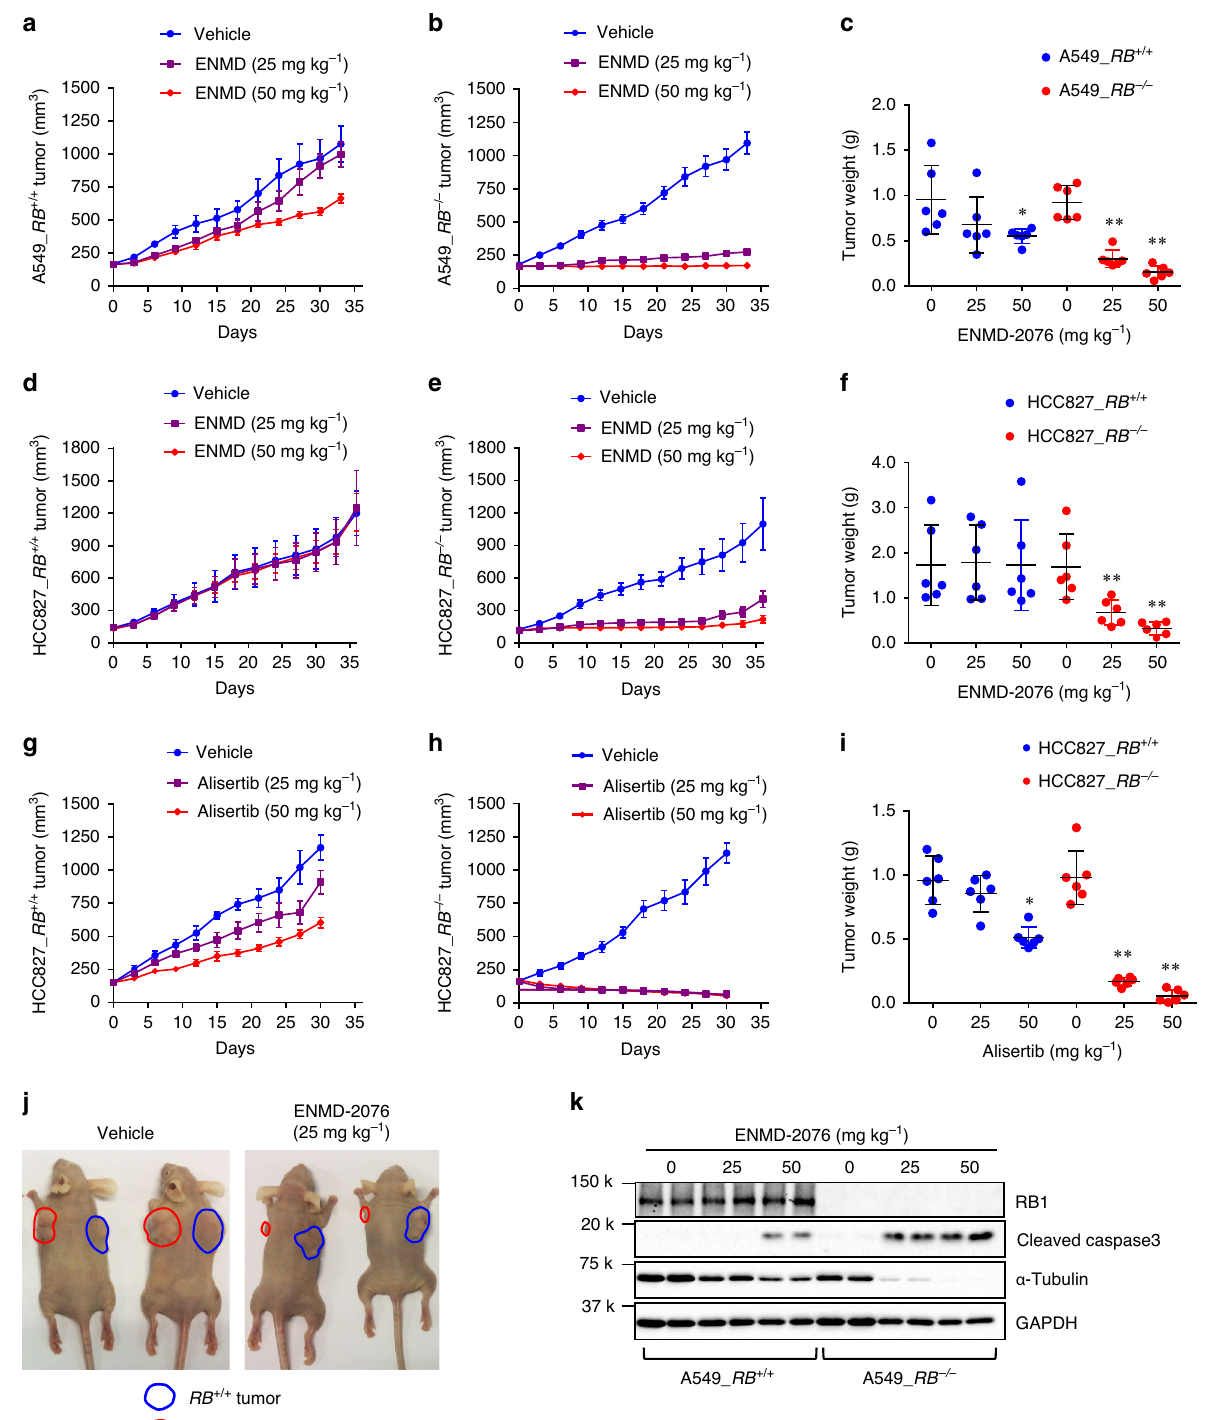
Fig. 2 AURKA inhibitors induce synthetic lethality in RB1 − / − lung cancer in vivo. Tumor growth curve of the A549 RB1 + / + ( a ) and RB1 − / − ( b ) lung cancer xenografts in mice treated with ENMD-2076. c Endpoint weight measurement of tumors isolated from the nude mice bearing A549 RB1 + / + and RB1 − / − lung cancer xenografts. Tumor growth curve of the HCC827 RB1 + / + ( d ) and RB1 − / − ( e ) lung cancer xenografts in mice treated with ENMD-2076. f Endpoint weight measurement of tumors isolated from nude mice bearing HCC827 RB1 + / + and RB1 − / − lung cancer xenografts. Tumor growth curve of the HCC827 RB1 + / + ( g ) and RB1 − / − ( h ) lung cancer xenografts in mice treated with alisertib. i Endpoint weight measurement of tumors isolated from nude mice bearing HCC827 RB1 + / + and RB1 − / − lung cancer xenografts. Data are presented as mean ± SD ( n = 6 independent animals per group). * P < 0.05; ** P < 0.01 vs no treatment control, determined using two-sided Student ’ s t test. j Representative images of vehicle-treated and ENMD-2076- treated nude mice bearing A549 RB1 + / + and RB1 − / − lung cancer xenografts. Tumor areas are indicated with dotted lines. k Western blot analyses of expression levels of RB1, cleaved caspase3, and α -tubulin in the tumor tissues. GAPDH was used as a loading